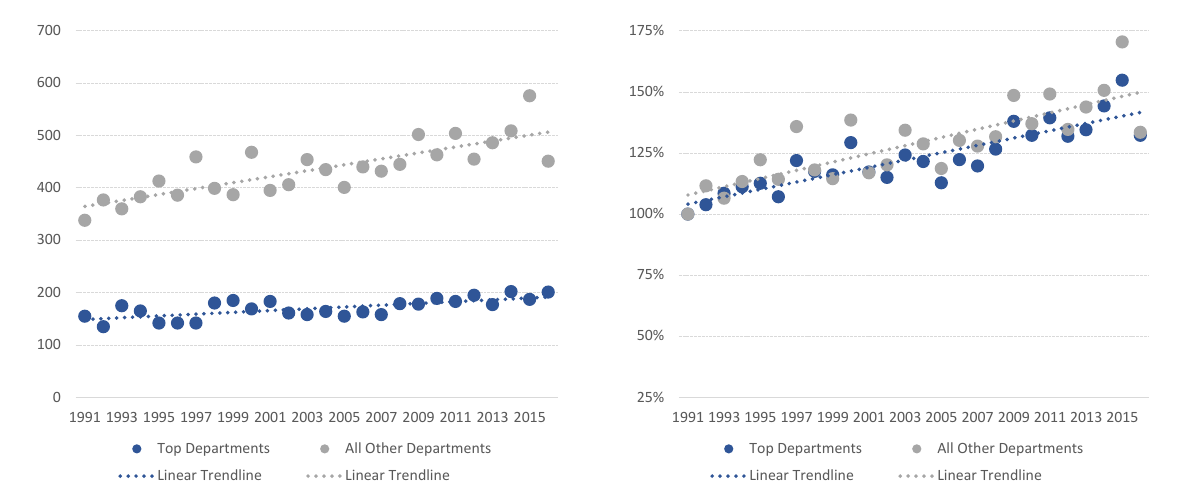
Figure 5: PhDs awarded, top sociology departments versus all others by year. Shown are the number of PhDs awarded and the percentage increase relative to